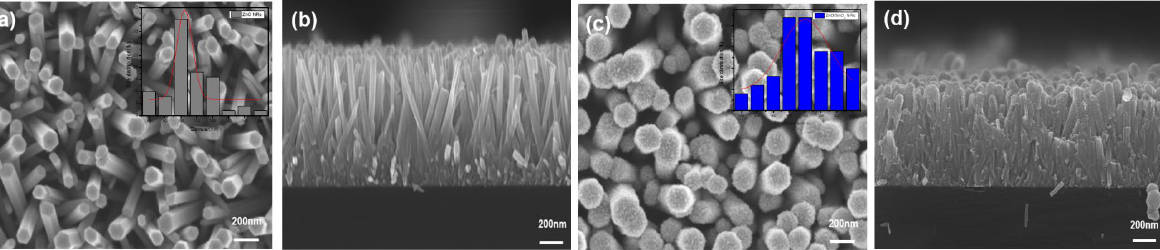
Figure 2. SEM images of the ZnO PD and ZnO/SnO 2 PD. ( a ) SEM image of ZnO NRs. The inset shows the diameter size distribution of ZnO NRs. ( b ) Cross-sectional view of ZnO NRs. ( c ) SEM image of ZnO/SnO 2 NRs. The inset shows the diameter size distribution of ZnO/SnO 2 NRs. ( d ) Cross-sectional view of ZnO/SnO 2 NRs.